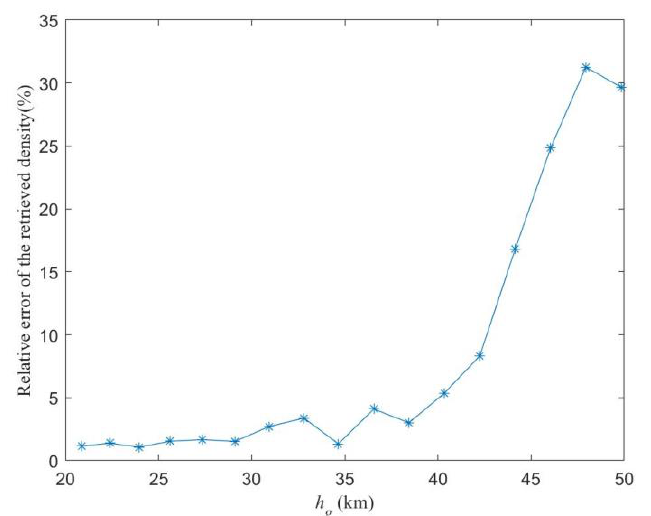
Figure 18. Relative error of the retrieved density with the tangent height in one simulation. According to the analysis in Section 3, the vertical resolution is 200 m for the retrieval herein. The horizontal coverage percentage in 100 h reaches 96% if the latitudinal and the longitudinal resolutions of the retrieved stratospheric density are 1° and 5°, respectively. In a small region, the spherically stratified atmosphere has little impact on the navigation by the stellar refraction. That is, the impact of the horizontal resolution on the navigation can be neglected if the latitudinal and the longitudinal resolutions of the retrieved strato- spheric density are as high as 1° and 5°, respectively. However, the vertical resolution will impact on the navigation directly. Figure 19 depicts the uncertainty on the apparent height with the vertical resolution of the atmospheric data. Herein, as mentioned above, the ap- parent height acquired by using the atmospheric data with the vertical resolution of 10 m was treated as the reference. That is, the uncertainty on the apparent height with a vertical resolution of the atmospheric data, r v , is the difference between the apparent height with r v and that with the vertical resolution of 10m. In Figure 19, the uncertainty on the appar- ent height was approximately proportional to the vertical resolution. Hence, both the ac- curacy of the retrieval and the vertical resolution should be taken into account in evaluat- ing the impact of the retrieved density on the navigation comprehensively. For example, according to simulations, the RMS value of the uncertainty on the apparent height was 166 m if the relative error of the retrieval was 0.9% at the tangent height of 30 km and the vertical resolution was 200 m by the star occultation. However, the RMS value of the un- certainty on the apparent height is 735 m if the relative error of the retrieval is 0.3% under the tangent height of 30 km and the vertical resolution is 1.4 km by the GPS radio occul- tation. Hence, the retrieval by the star occultation is more suitable for the navigation by the stellar refraction to achieve a higher accuracy than that by the GPS radio occultation.